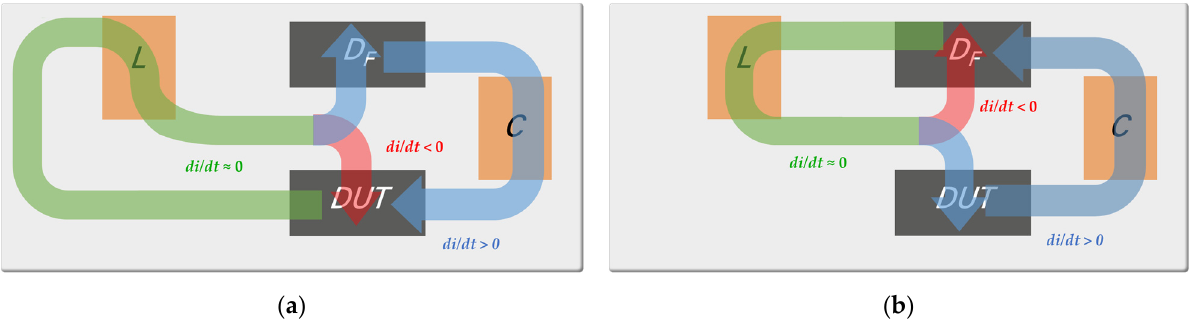
Figure 4. Dynamic power loop. ( a ) Turn-off path. ( b ) Turn-on